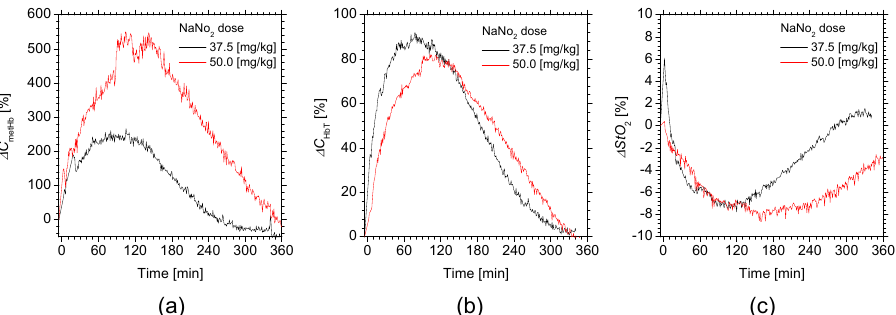
Figure 6. Time courses of ( a ) Δ C metHb , ( b ) Δ C HbT , and ( c ) Δ StO 2 Δ C m averaged over two rats for different doses of NaNO 2 .